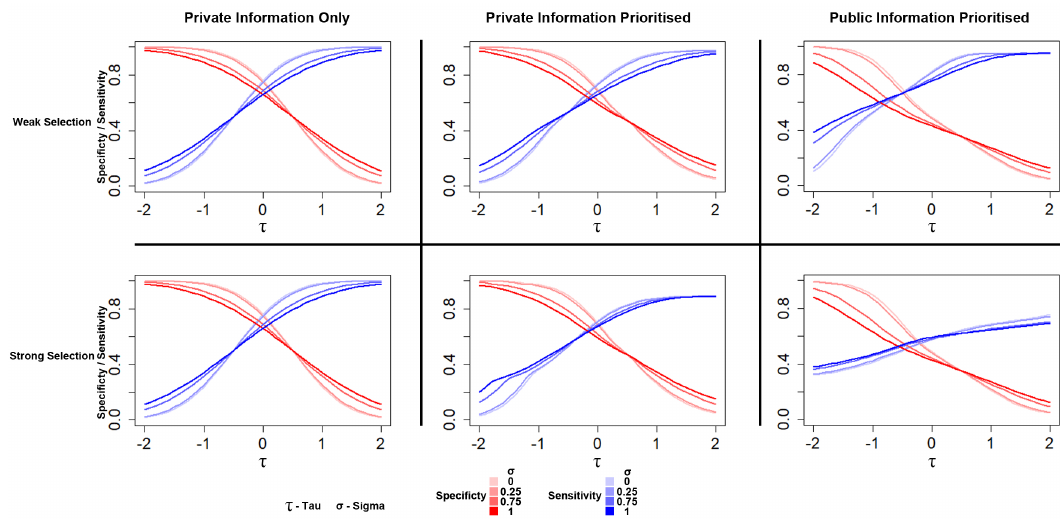
Figure 5. Specificity and sensitivity of individual decision making. Plots visualise and compare the specificity and sensitivity values that were recorded from simulations. In general, as diversity of opinion diversity is increased, nodes are able to better identify cheaters at higher τ settings. τ represents the decision threshold. σ represents opinion diversity. Data obtained by running the model for 10 8 steps. Plots produced via RStudio utilising code found in Appendix